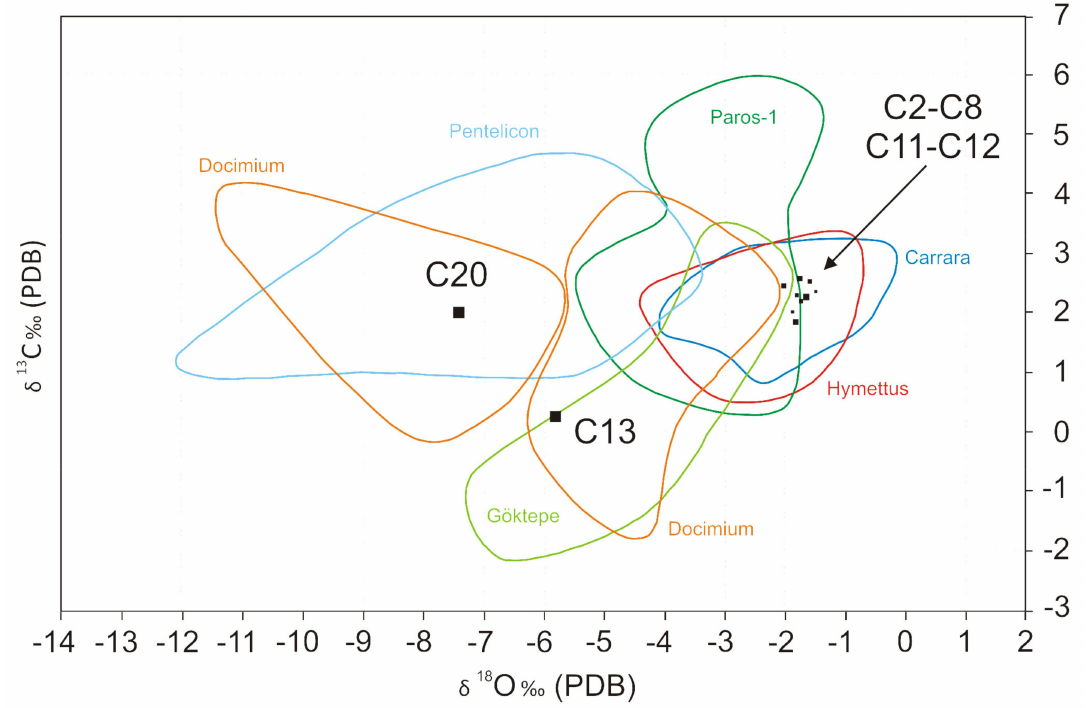
Figure 5. Comparison of the isotopic signatures of the marbles coming from Tauriana with the data for fine-grained marbles used in antiquity [21].